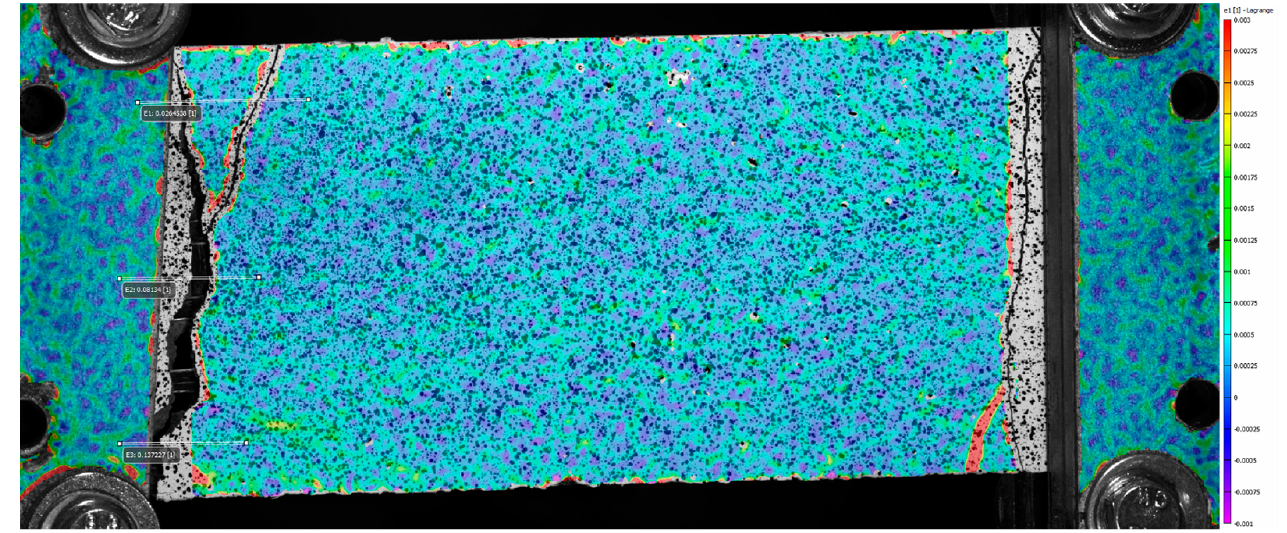
Figure 5. The virtual extensometer on the BP-A specimen. The color scale represents the grade of the major principal strains, from 0.003 units in red to − 0.001 units in purple.